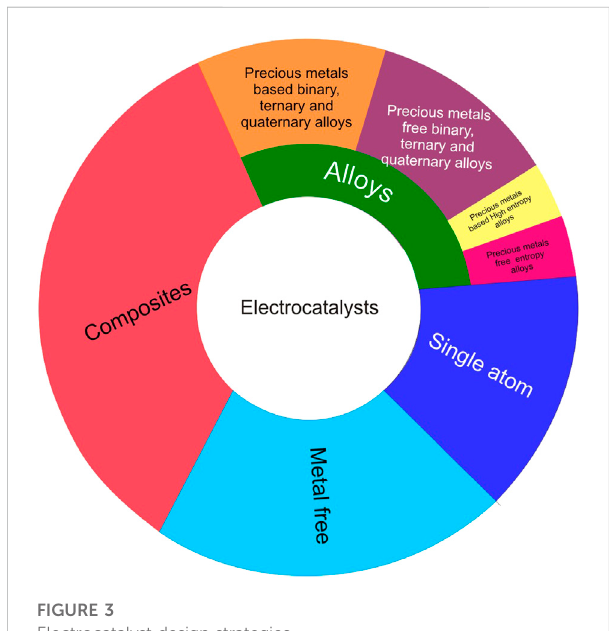
FIGURE 3 Electrocatalyst design